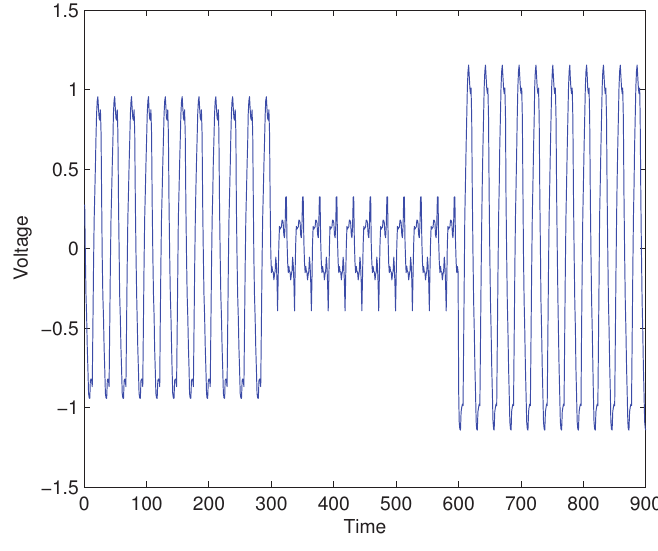
Figure 4. Waveform of test signal (Case